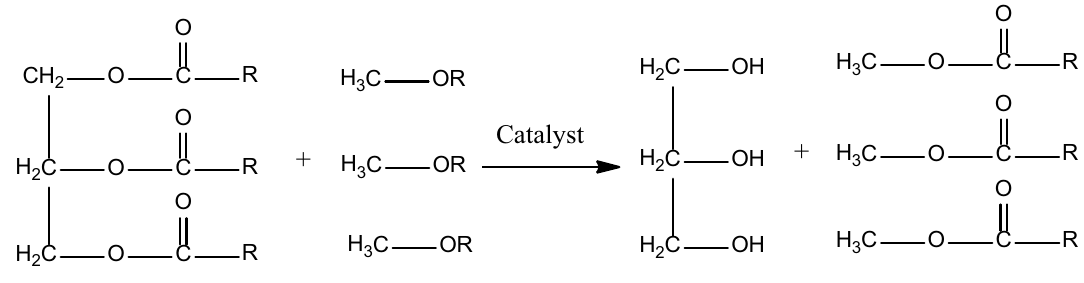
Figure 1. General reaction scheme for